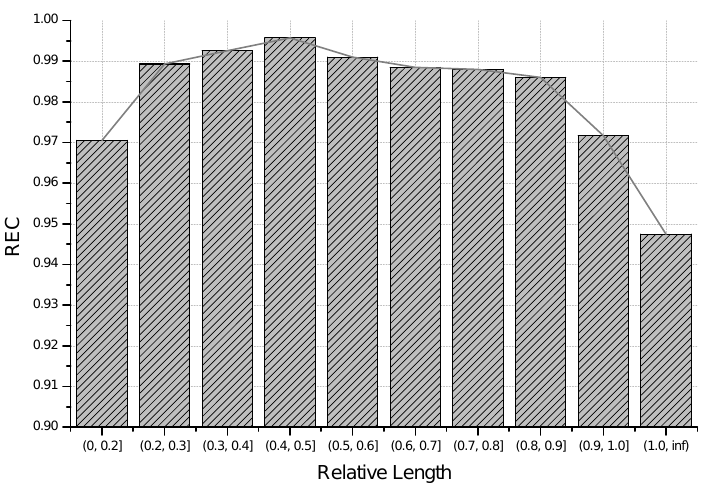
Figure 10. Detection capability on payloads of different